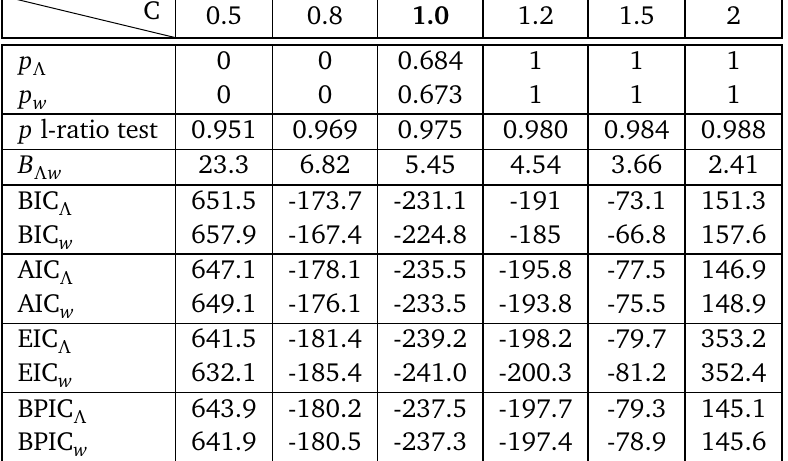
by a factor C , i